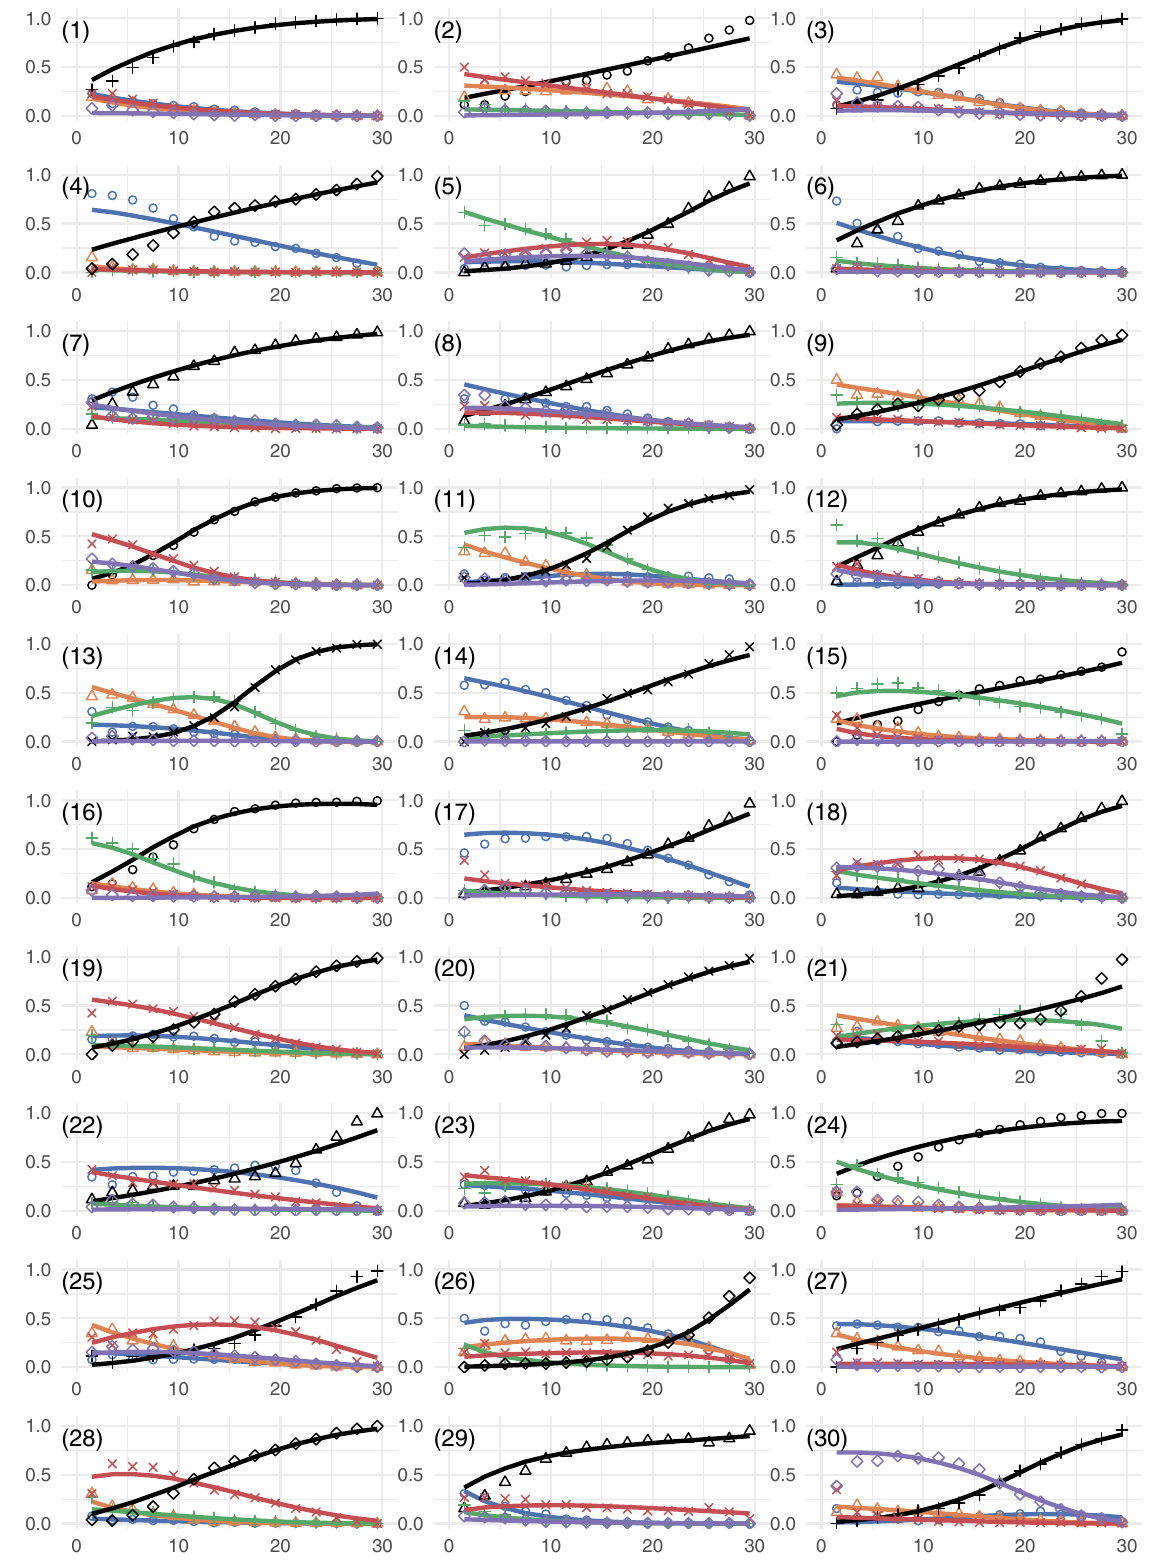
FIG. 1. Item response curves for all FCI items in the aggregated dataset plotted as individual symbols. For incorrect responses, (A) is blue (circle), (B) is orange (triangle), (C) is green (plus), (D) is red (cross), and (E) is purple (diamond). Item characteristic curves for the 1D NRM for all FCI items in the aggregated dataset are drawn as solid